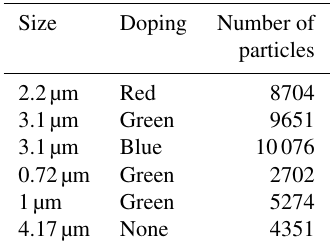
Table 1. Sample sizes for PSLs.